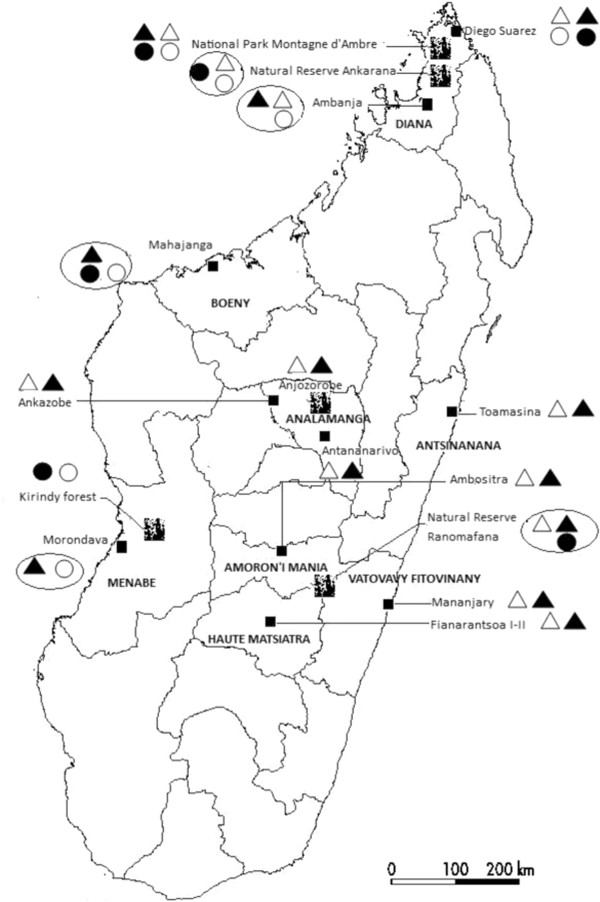
Distribution of Aedes mosquitoes in eight regions of Madagascar. Empty triangle Aedes albopictus and empty circle Aedes aegypti in the 1980s (Ravaonjanahary, 1978; Fontenille et al., 1989). Filled triangle Aedes albopictus and filled circle Aedes aegypti at the end of 2009 (this study). Encircled symbols highlighted changes in species distribution. Black filled square, town. Mosaic square, forest areas.